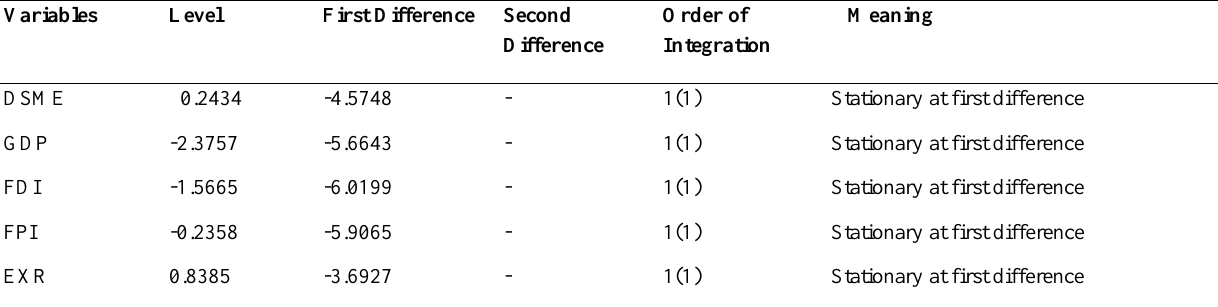
Table 5: Augmented Dickey-Fuller (ADF) Test for Unit Root